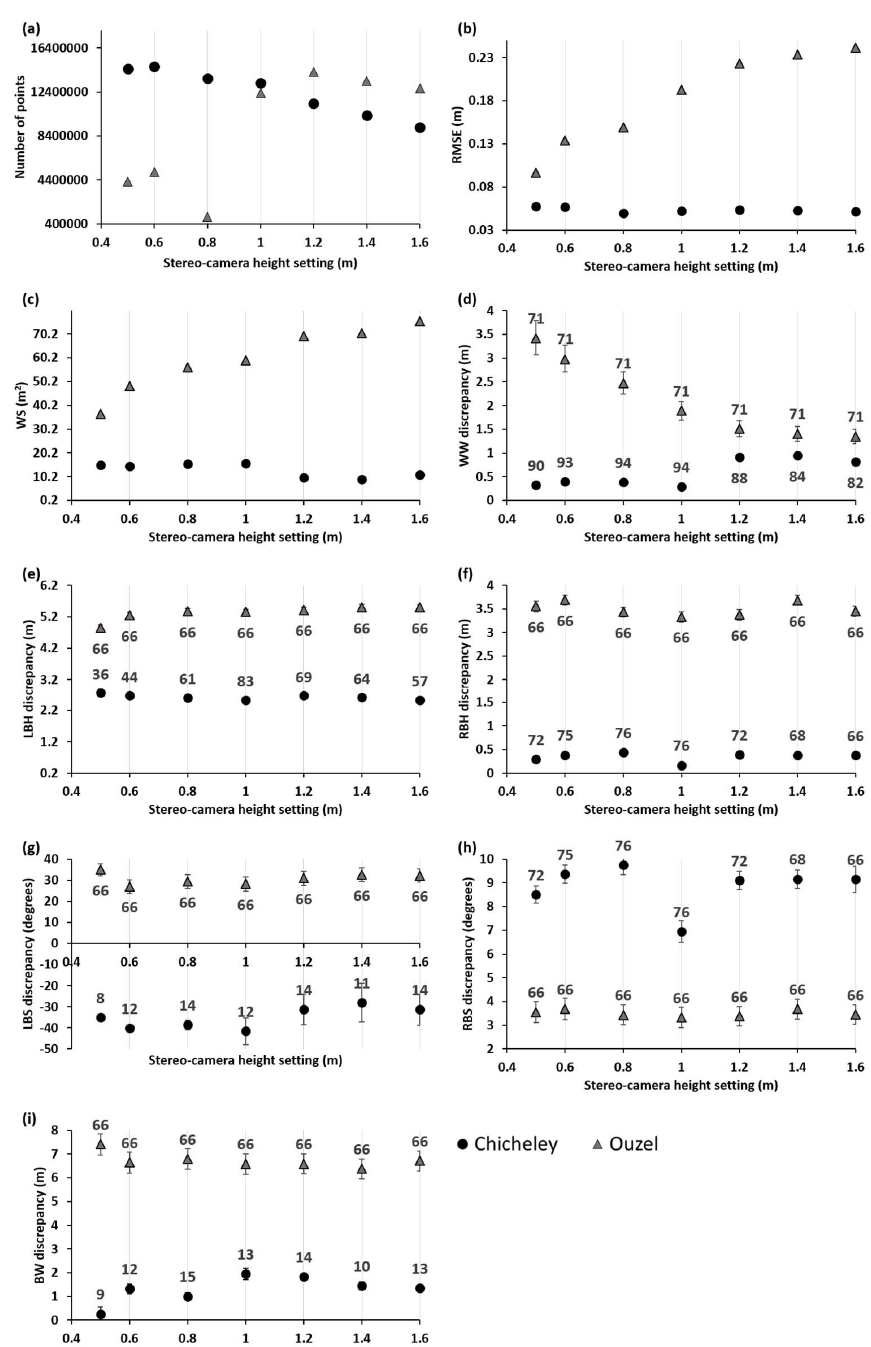
Figure 8. Summary of outcomes obtained for the stereo-camera height study along the 10 m reaches at the Chicheley Brook and River Ouzel. ( a ) Number of points; and ( b ) Root Mean Square Error (RMSE) of distance measurements (m) of the point clouds obtained for each stereo-camera height setting tested. The RMSE of distance measurements of the Structure-from-Motion (SfM) point cloud was estimated with respect to the total laser scanner (TLS) point cloud. ( c ) Water surface area obtained for the Chicheley Brook and River Ouzel sites. Discrepancy (error) between hydromorphological measures obtained for the SfM and TLS point clouds are reported as follows: ( d ) mean wetted water width; ( e ) mean left bank height; ( f ) mean right bank height; ( g ) mean left bank slope; ( h ) mean right bank slope; and ( i ) mean bankfull width. The error bars denote the SE, whereas the labels indicate the number of valid cross-sections used in the estimation of the measure average.